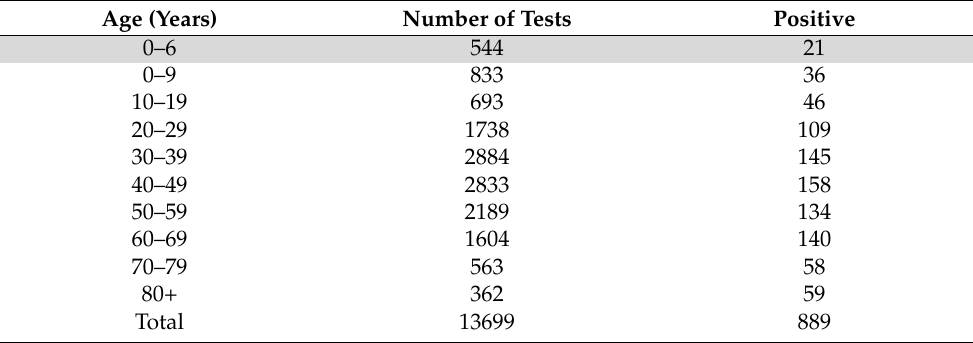
Table 1. The number of tests and positive cases in the different age